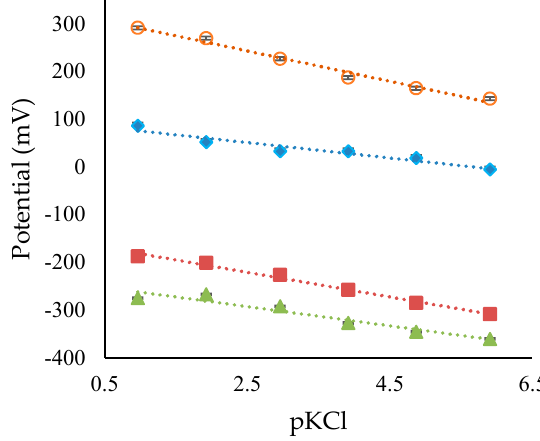
Figure 4. KCl sensitivity of RuO 2 pH sensors with, RuO 2 -SiO 2 (Red Squares), RuO 2 -SiO 2 -KCl (Green Triangles), Glued-RuO 2 (Aqua Diamonds), and AgCl-KCl (Orange Circles) reference electrodes.